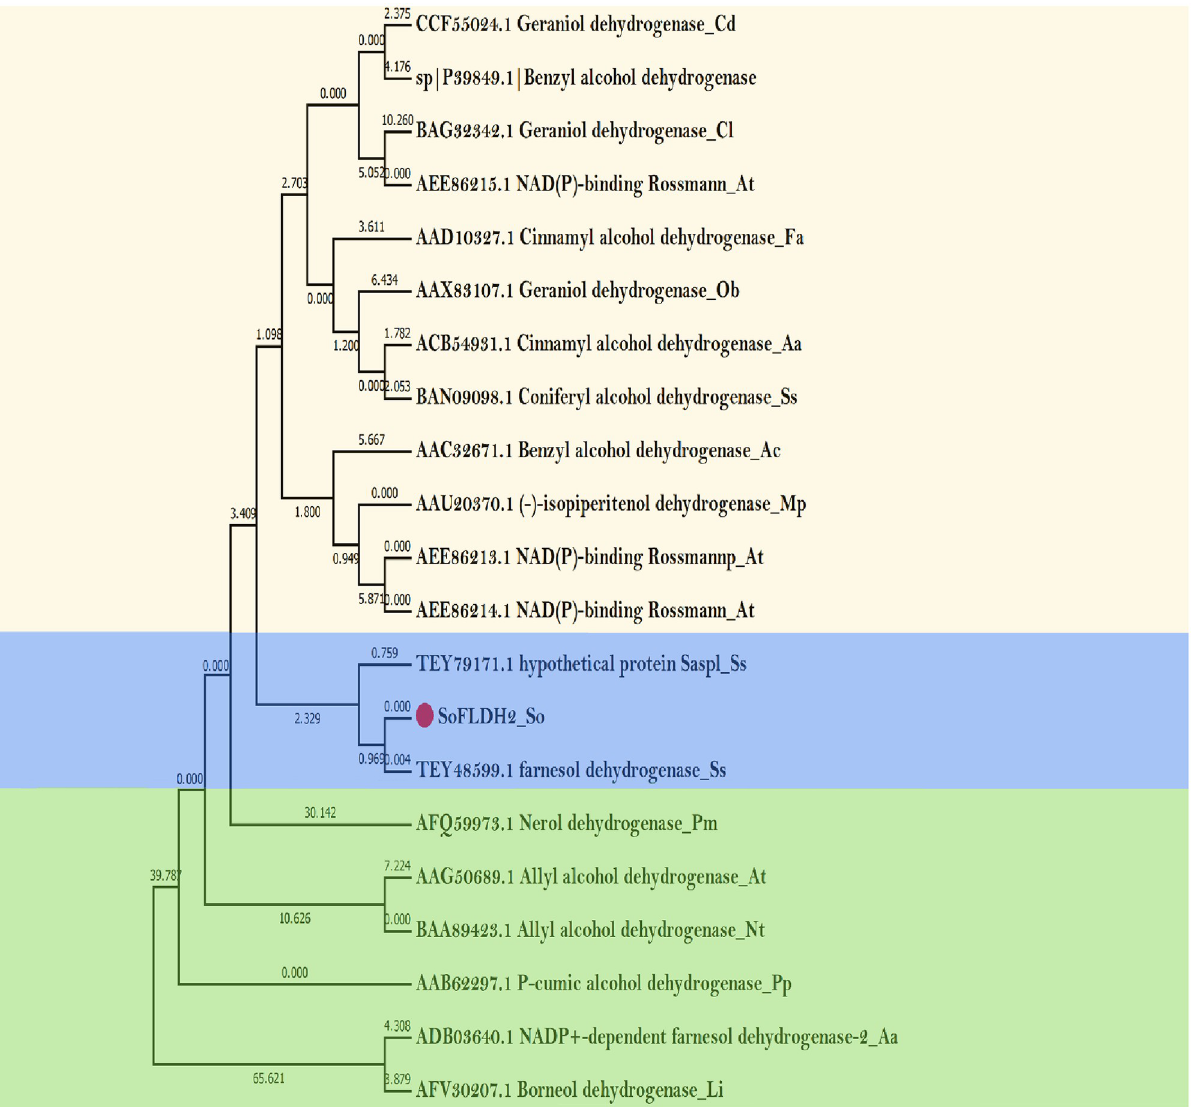
Fig 1. Phylogenetic analysis of SoFLDH gene from S . officinalis and other plants, based on the primary amino acid sequences. A maximum likelihood tree was constructed for SoFLDH gene using MEGA 6.6 program with default parameters. The percentage of bootstrap values is provided in the branches. Sequences are labeled with the accession numbers and species